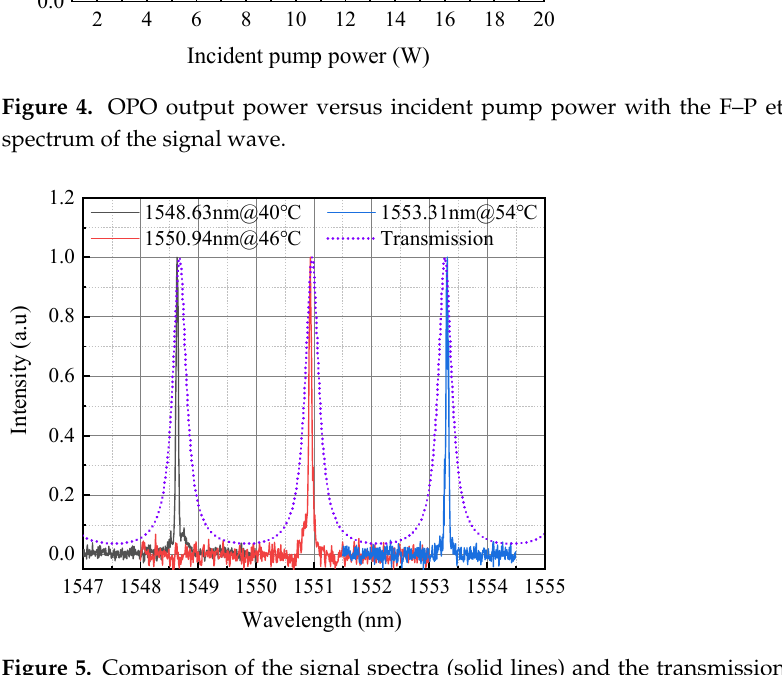
Figure 5. Comparison of the signal spectra (solid lines) and the transmission curve of the etalon (dotted line).